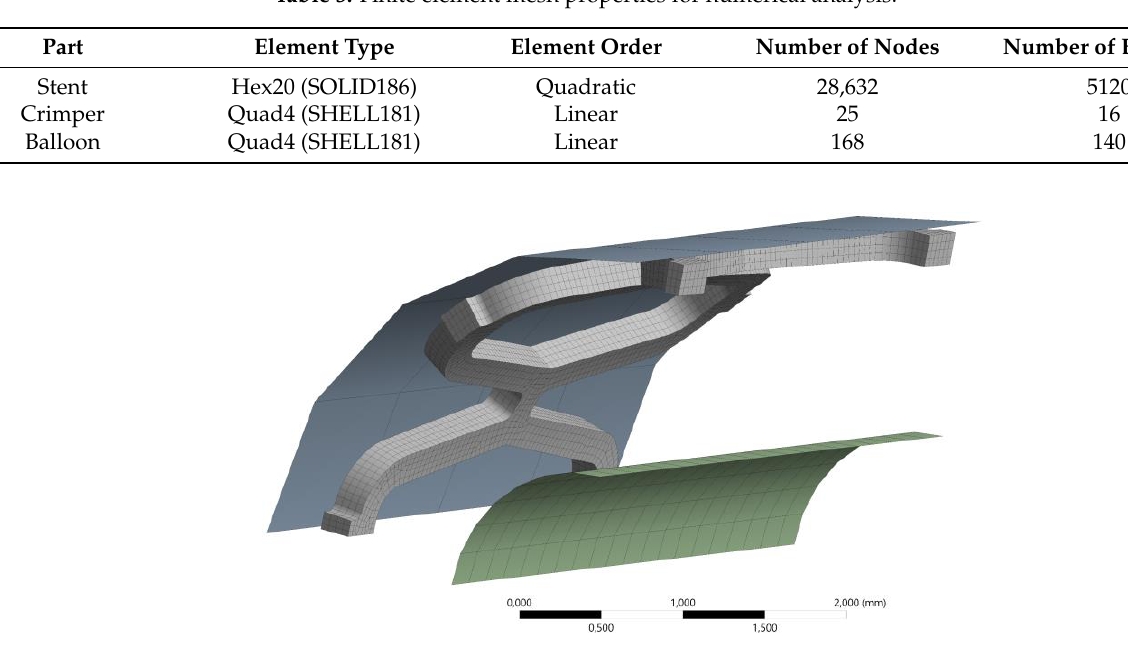
Figure 3. Finite element mesh for numerical analysis.